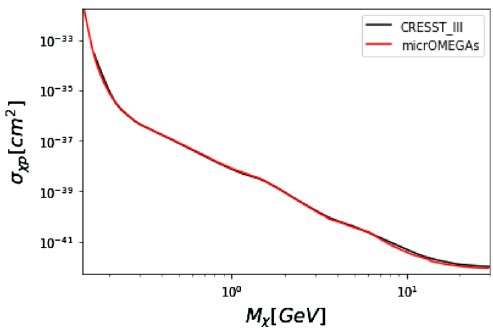
Fig. 4 Comparison of PICO SI 90% excluded cross section with our reconstructions based on Feldman–Cousins (FC) and Neyman methods Fig. 5 Comparison of the reconstructed exclusion for SI interactions from micOMEGAs with